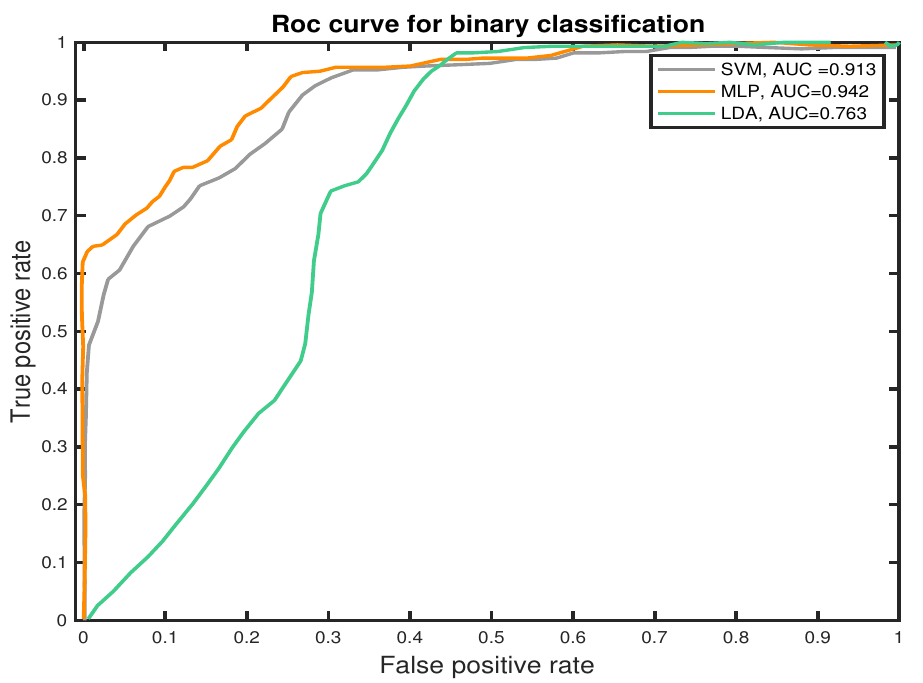
Figure 9. ROC curves of the proposed SVM, LDA, and MLP classifiers for binary classification task (PNES versus